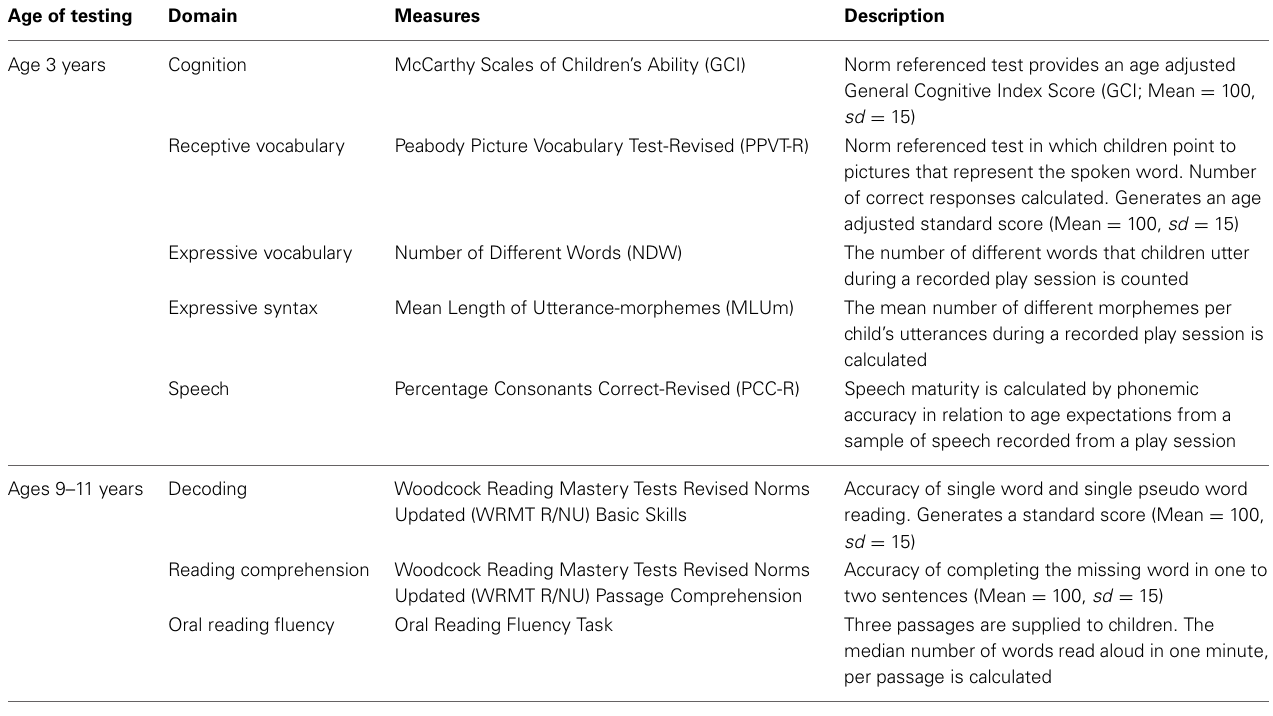
Table 1 | Summary of domains of function and measures to evaluate language, speech, cognition, and